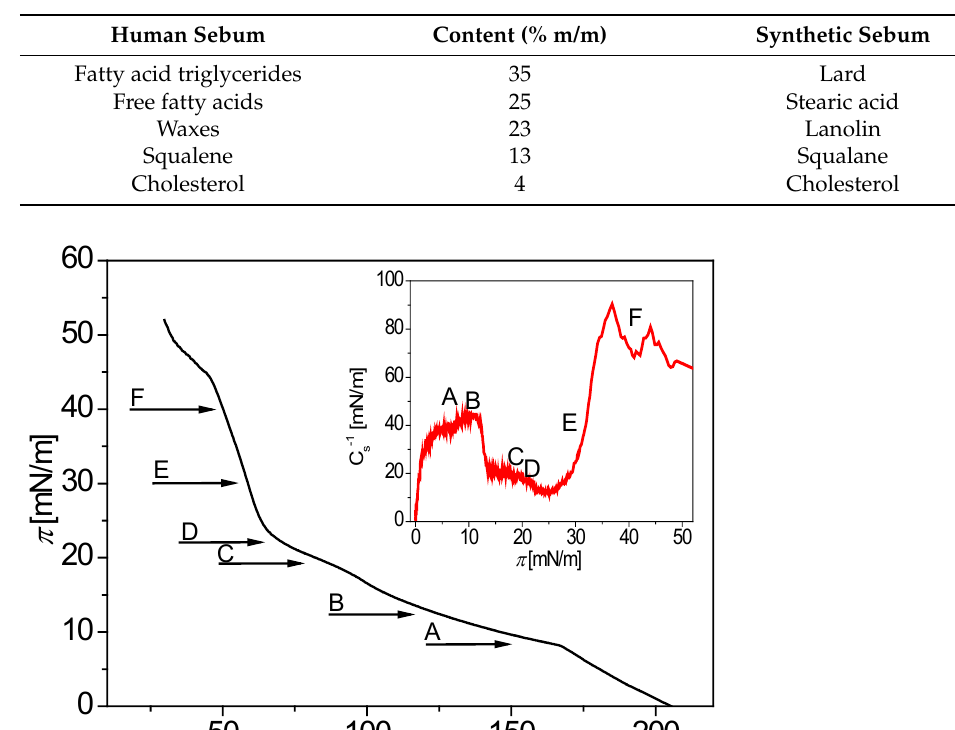
with the rate of 7 mm/min for C s − 1 ). C s − 1 , being registered under conditions closer to G ( C s − 1 < 12.5 mN/m), liquid expanded, LE (12.5 mN/m < C s − 1 < 50 mN/m), liquid